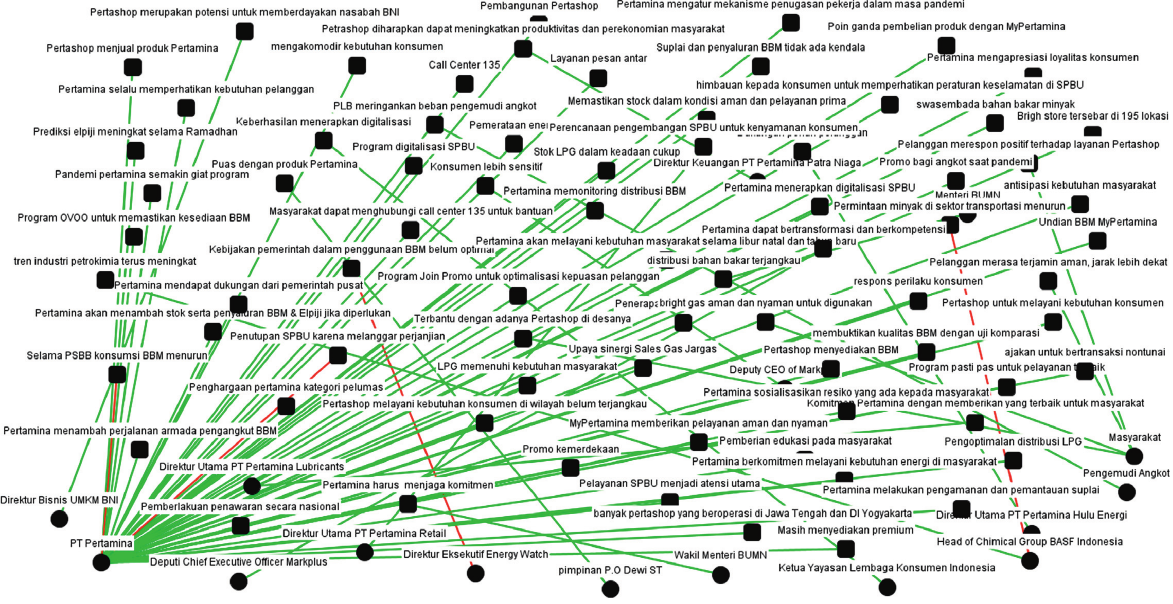
Figure 2: Actors and issues of PT Pertamina.